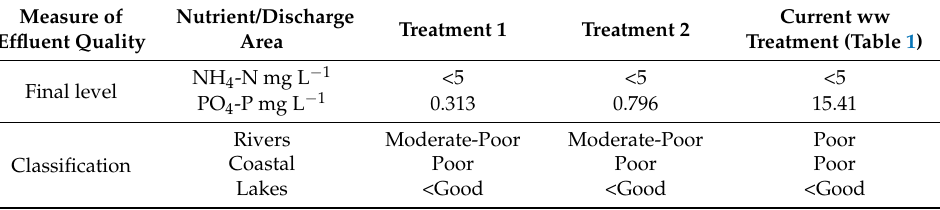
Table 3. Classification of the quality of wastewater following bioremediation by C. vulgaris compared to current wastewater treatment.